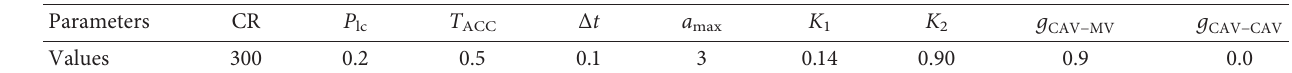
Table 3: Parameters for